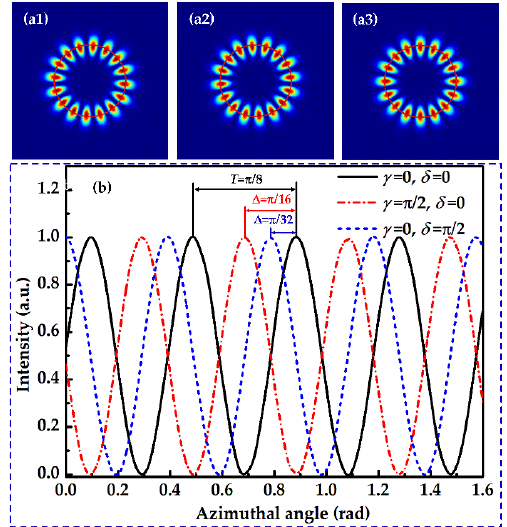
Figure 3. Theoretical intensity distribution of the cylindrical vector beam ( θ = 0) through P 2 . ( a1 ) γ = 0, δ = 0; ( a2 ) γ = π /2, δ = 0; ( a3 ) γ = 0, δ = π /2. ( b ) Intensity curves in the centroid circles of the cylindrical vector beams versus the azimuthal angle ϕ .